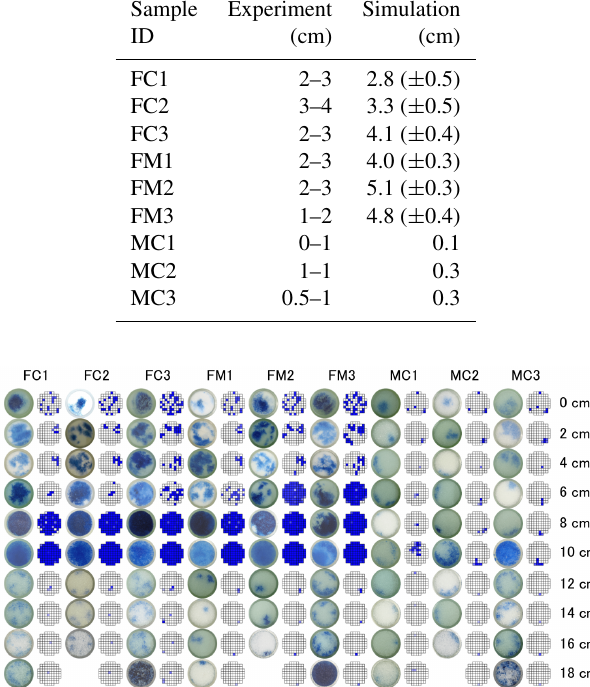
Table 3. Thickness of the upper layer affected by ponding at the layer boundary. For each pixel at the interface between layers, sim- ulated thickness was first determined by computing the number of voxels above with a liquid water content (LWC) of >10%. These data were then used to calculate a mean value and its standard devi- ation.